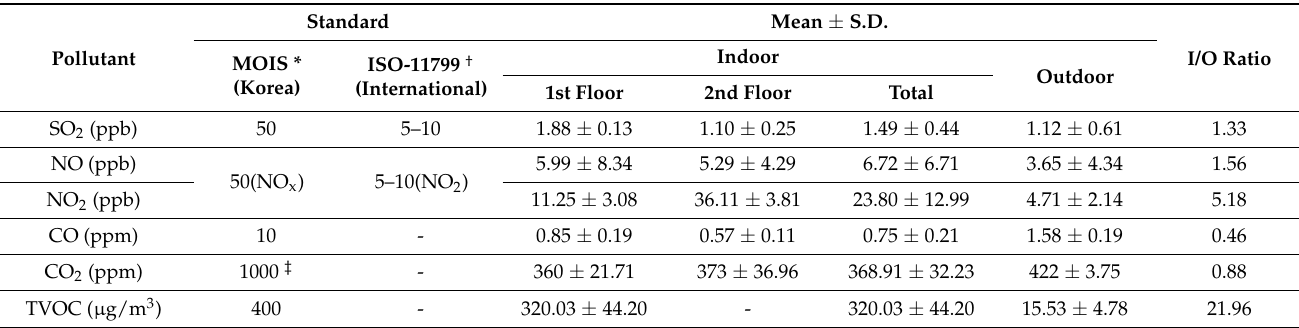
Table 4. Concentrations of air pollutants in the valuable archive and air pollution standards. TVOC—total volatile organic